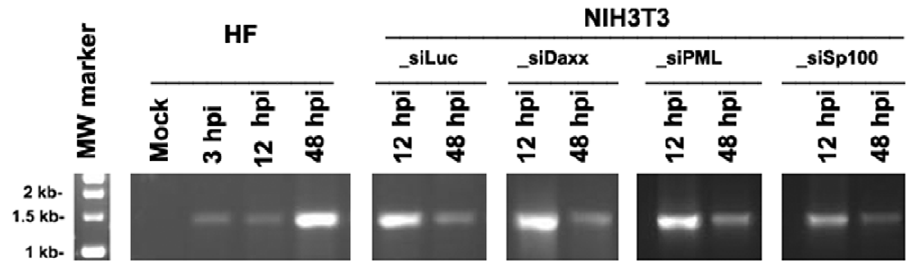
Figure 8. Detection of HCMV DNA after infection in NIH3T3 and Mrc-5 cells. siRNA was used to transfect NIH3T3 cells; 12 hours after transfection, the cells were infected with repaired AD169 at an MOI of 1; using a modified Hirt method (7), viral DNA was prepared from MRC-5 cells (left) or NIH3T3 cells (right) at the indicated post-infection times. PCR was performed using the primers (described in the Material and Methods) and PCR products were run on an agarose gel to visualize the DNA (using a UV light).